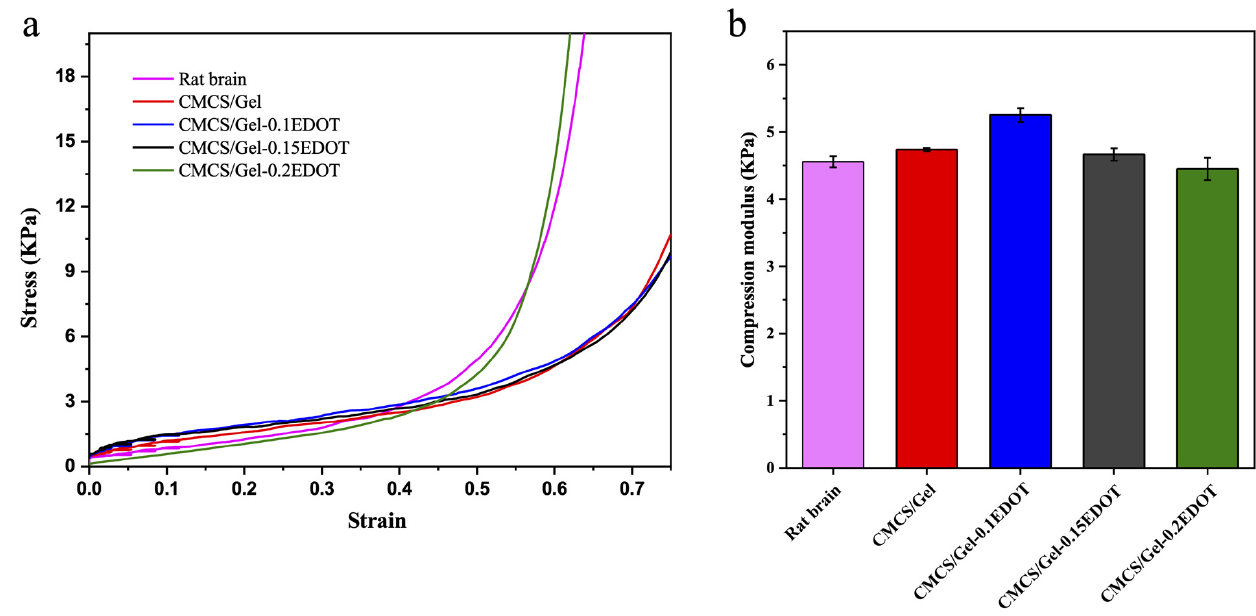
Figure 6. Stress–strain curves ( a ) and compression modulus ( b ) of CMCS/Gel, CMCS/Gel-PEDOT hydrogels and the brain tissue of newborn SD rat.